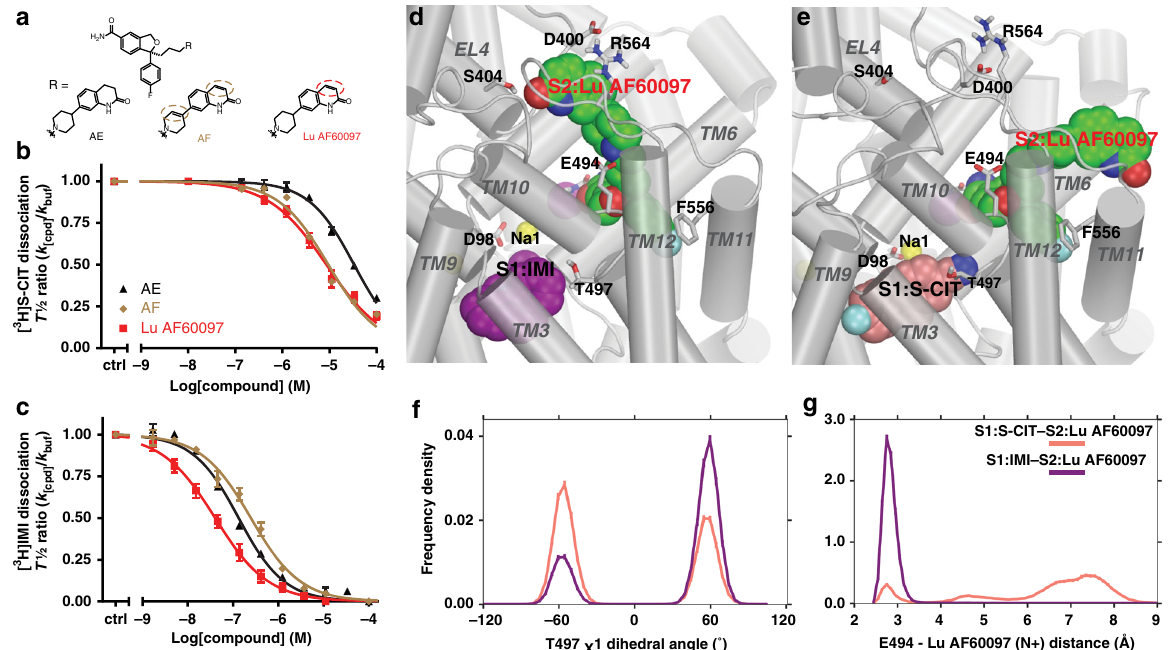
Fig. 3 Identi fi cation of high-af fi nity allosteric inhibitors for SERT. a Chemical structure of three tested compounds, all based on S-CIT template with an amide instead of the cyano in S-CIT. They differ in having either none (AE), one (Lu AF60097) or two (AF) double bonds (stippled circles) in their N-substituent. b The allosteric potency of the compounds inhibiting the dissociation of [ 3 H]S-CIT is within the micromolar range: Lu AF60097 (red), IC 50 = 6.50 [5.07; 8.31] µ M; AF (brown), IC 50 = 10.4 [8.45; 12.9] µ M; and AE (black), IC 50 = 33.8 [30.7; 37.3] µ M. Data are mean [S.E. interval], n =